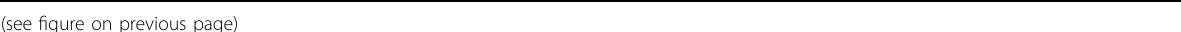
(see fi gure on previous page) Fig. 5 Experimental results of a four-function doublet. a Schematic of the doublet composed of a dual-function cylindrical lens with NA ~ 0.14 as the converging element and the multi-perturbation device in Fig. 3 with NA ~ 0.05 as the diverging element. Bright fi eld optical microscope images of the diverging ( b ) and converging ( c ) elements. SEM images of the diverging element at its center ( d ) and converging element at its corner ( e ). Arrows indicate the direction of the phase gradient. f Measured transverse intensity distributions for the four-function doublet at the shared focal plane. g Estimated Q-factors for the four lensing functions by integrating the optical intensity over the focal features (focal lines) as a function of wavelength (Supplementary Section 10). Device dimensions are detailed in Table S1